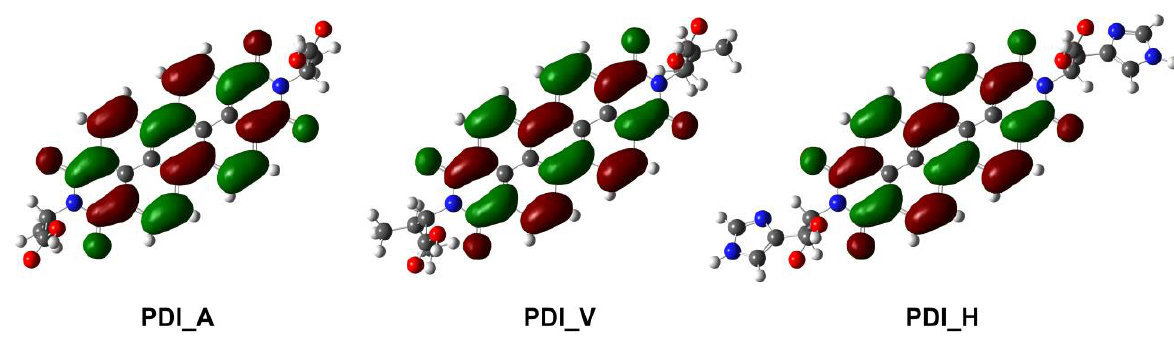
Figure 2. Optimized structure and LUMO diagram of PDI_A, PDI_V, and PDI_H resulting from DFT calculations. Red and green represents the positive and negative phase of molecular orbital wave function, respectively. Table 1. Relationship between the discharge potential and the LUMO level.